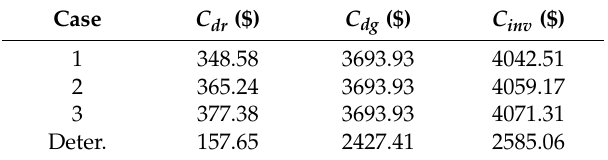
Table 8. Investment cost for a co-planning scheme in a different case of a 123-node test system. Case C dr ($) C dg ($) C inv